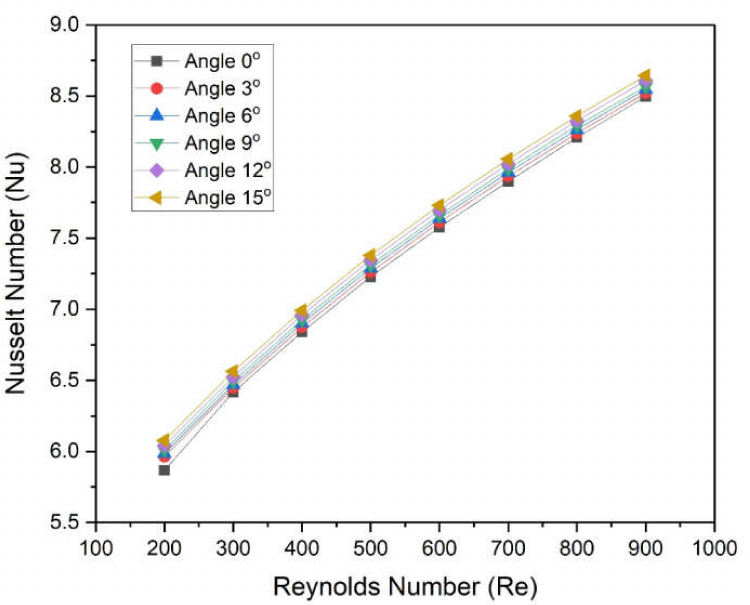
Figure 9. Variation in Nusselt number of microchannel heat sinks with Reynolds numbers for different